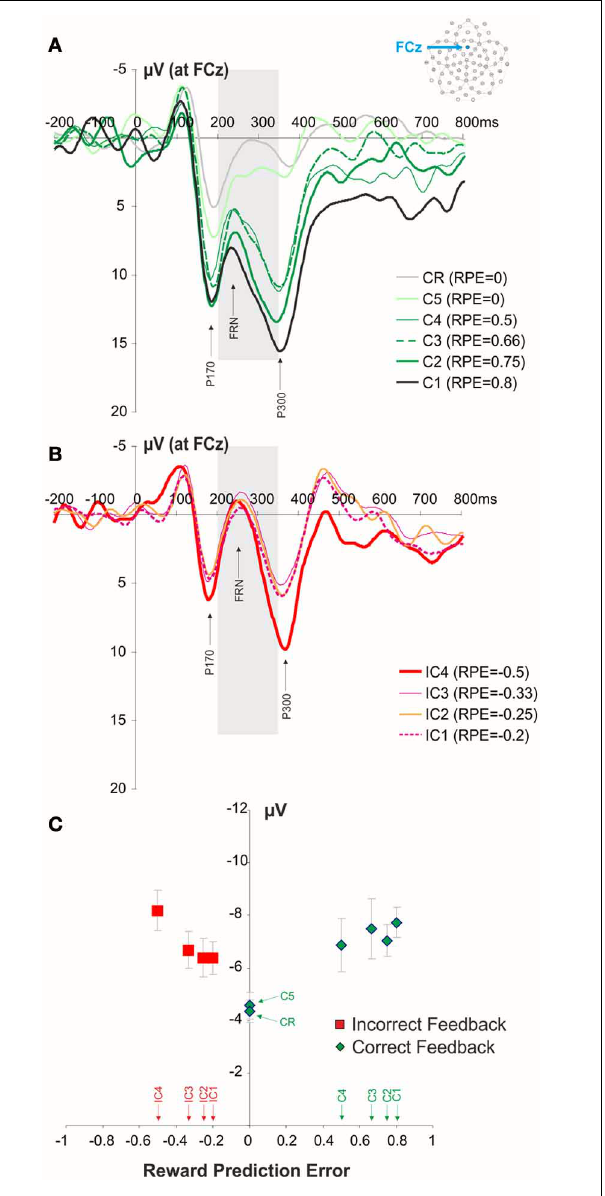
FIGURE 3 | Waveforms recorded at FCz at the presentation of the feedback and FRN modulation. (A,B) Average waveforms elicited by the different correct and incorrect feedbacks. The panel (A) illustrates the signals recorded for the different positive feedbacks (C1, C2, C3, C4, C5, CR). Similarly the panel (B) illustrates the signals recorded for the different negative feedbacks (IC1, IC2, IC3, IC4). The gray box is indicating the time windows of interest in which we measured the amplitude of FRN ( + 200 to + 350ms post feedback). (C) Modulation of FRN amplitude according to RPE quantified at FCz. Red and green symbols represent RPE values associated with negative and positive feedbacks, respectively. Feedback types corresponding to the different RPE values are indicated above the horizontal